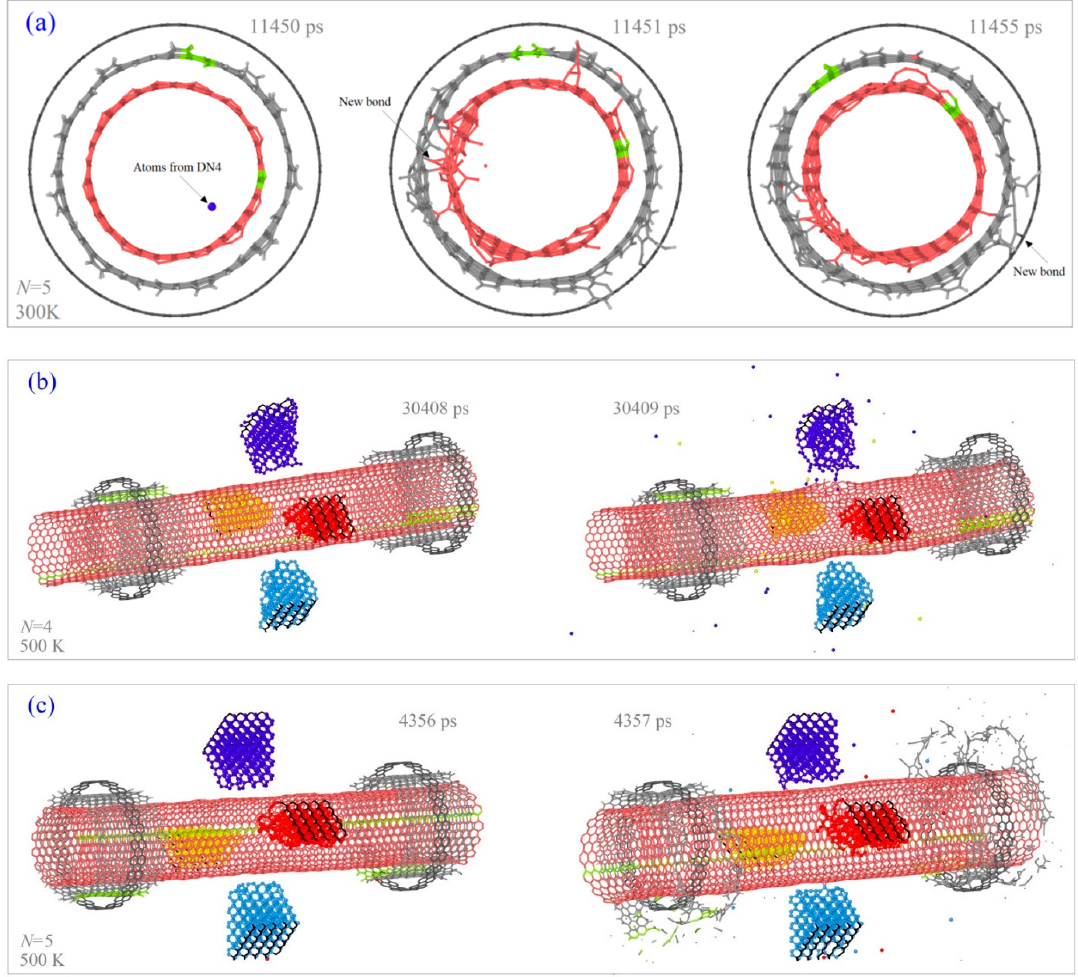
Figure 3. Snapshots of the system under different conditions. ( a ) Bonding process among the components in system with N = 5 at 300 K. ( b ) Sudden collapse of DNs with N = 4 at 500 K. ( c ) Sudden collapse of mid tubes in the system with N = 5 at 500